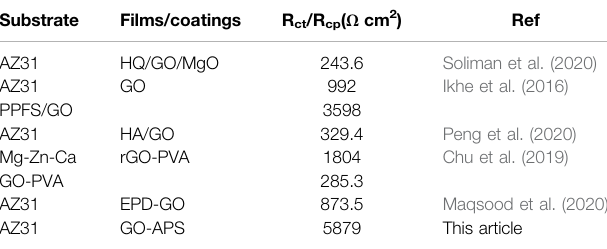
TABLE2| ComparisonofcorrosionresistanceofGO-based fi lms/coatingsonMg